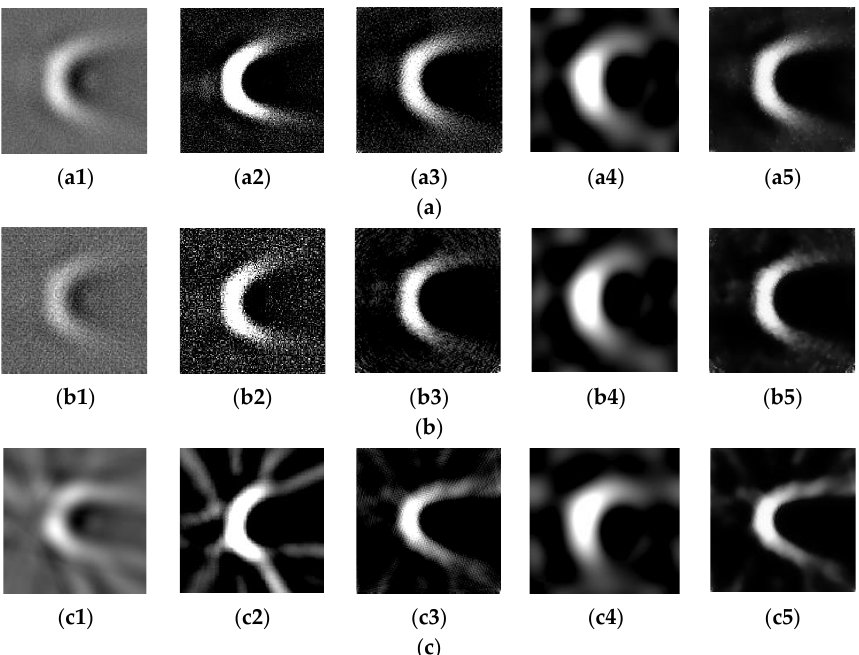
Figure 8. Second near-field experimental imaging results ( Far left ) iRadon; ( Left ) FBP; ( Middle ) ART; ( Right ) sparse ART with OMP; ( Far right ) TV sparse reconstruction with ART. ( a ) Complete view data with noise (a1:a5); ( b ) sampled data at 10°intervals with noise (b1:b5); ( c ) random sampled data at 10° intervals (c1:c5). Table 2. Comparison of anti-noise and random sampled results with the three metrics. IE NRSNR (dB) Var FBP